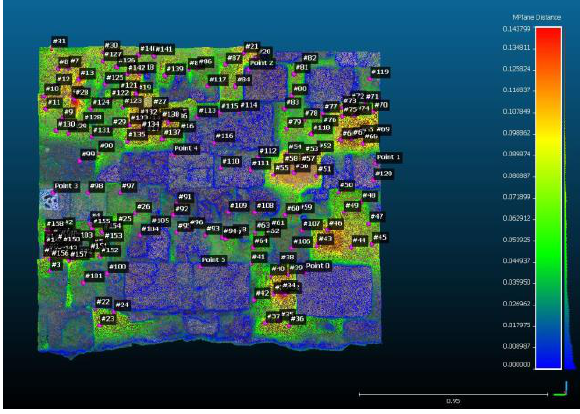
Figure 12. Detailed 3D Textured Model using HS bands 823 nm, 710 nm, 696 nm as RGB.